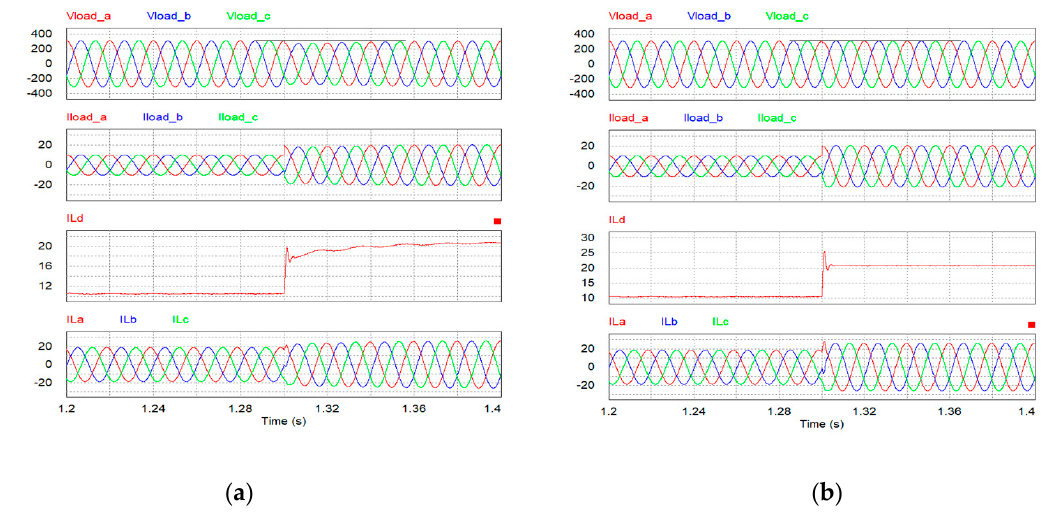
Figure 18. Simulation results in standalone mode with load variation: ( a ) using the general inverter controller; ( b ) using the proposed load current compensation controller.